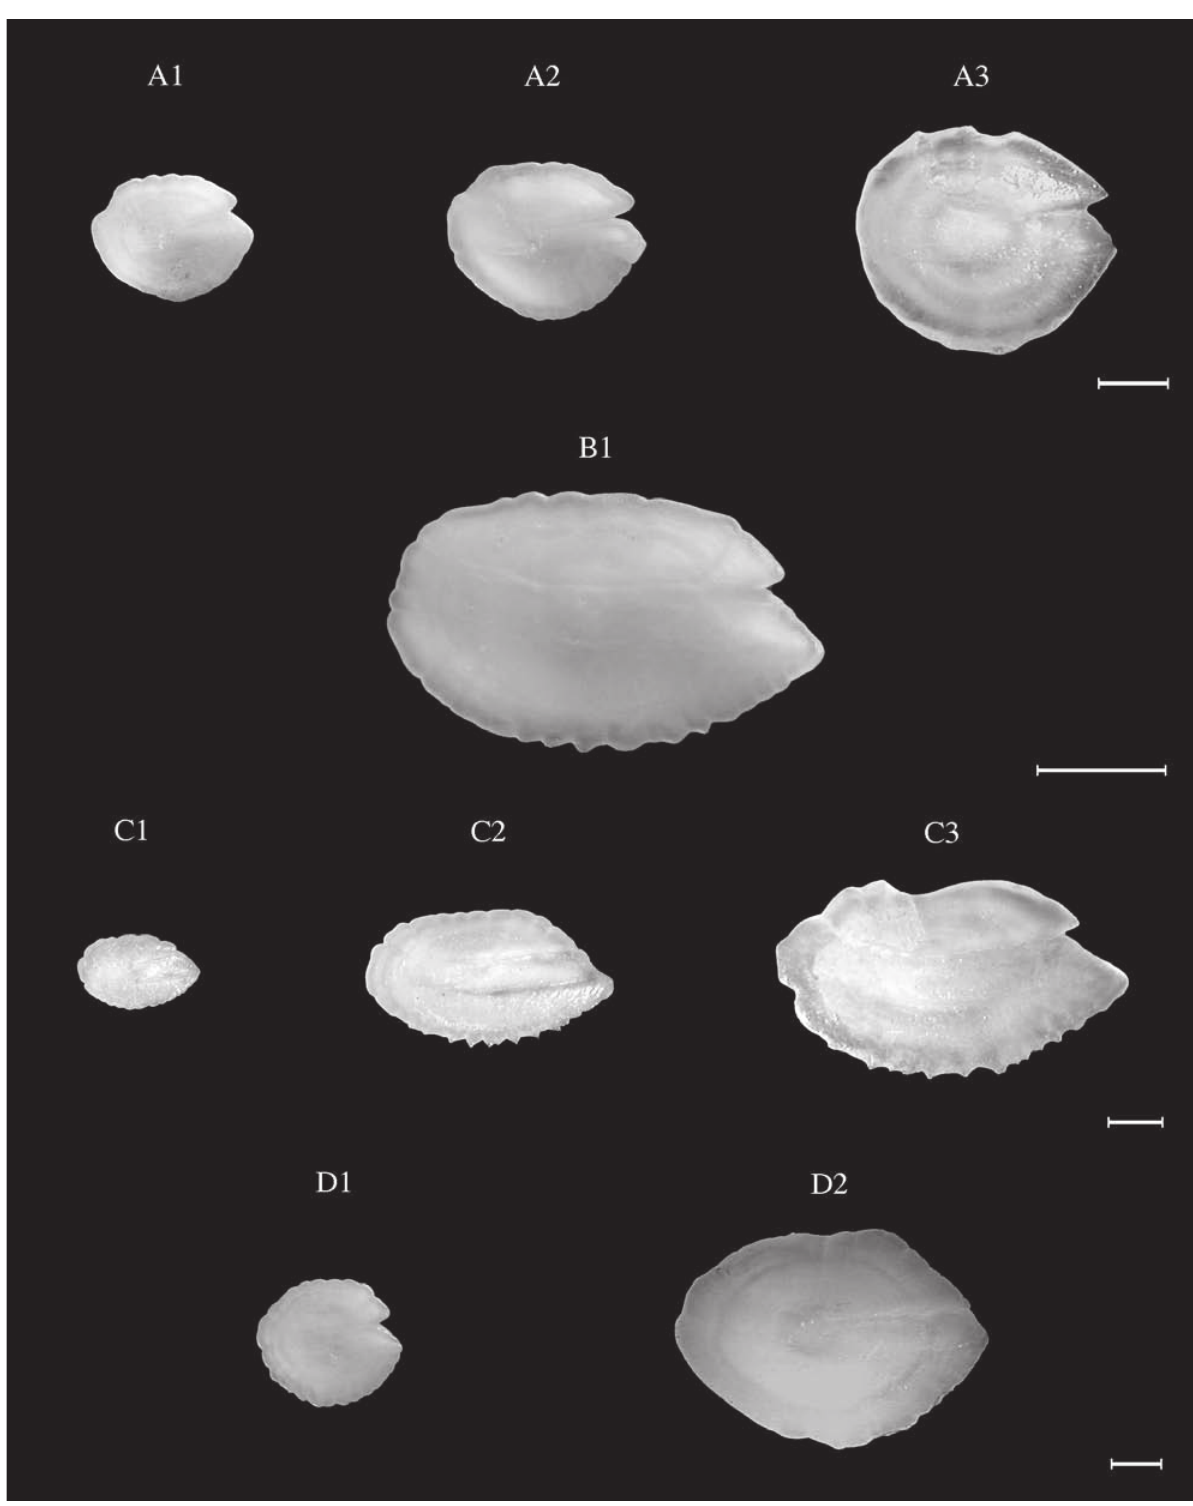
Fig. 23. – Myctophum punctatum . TL: A1, 5.5 cm (NEA); A2, 7.1 cm (NEA); A3, 9.0 cm (WM). Notoscopelus bolini (NEA). TL: B1, 8.6 cm. Notoscopelus elongatus (WM). TL: C1, 5.0 cm; C2, 9.5 cm; C3, 13.0 cm. Symbolophorus veranyi . TL: D1, 6.2 cm (NEA); D2, 13.0 cm (WM). Scale bar = 1